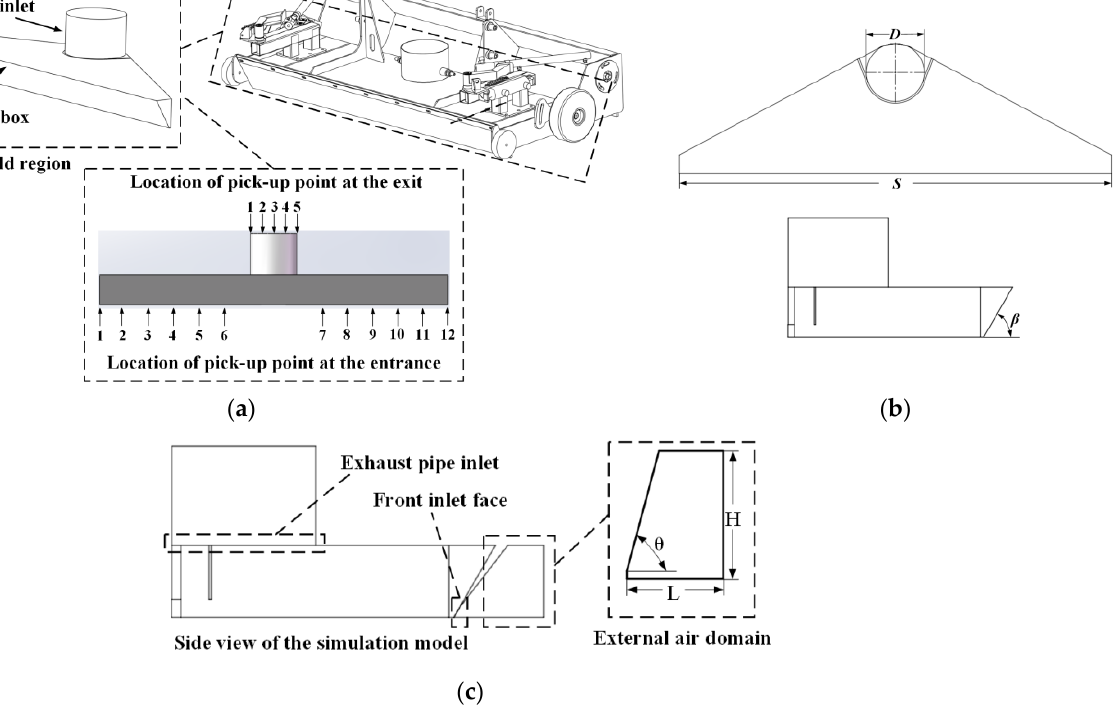
Table 1. The specific dimensions of the dust suction port.